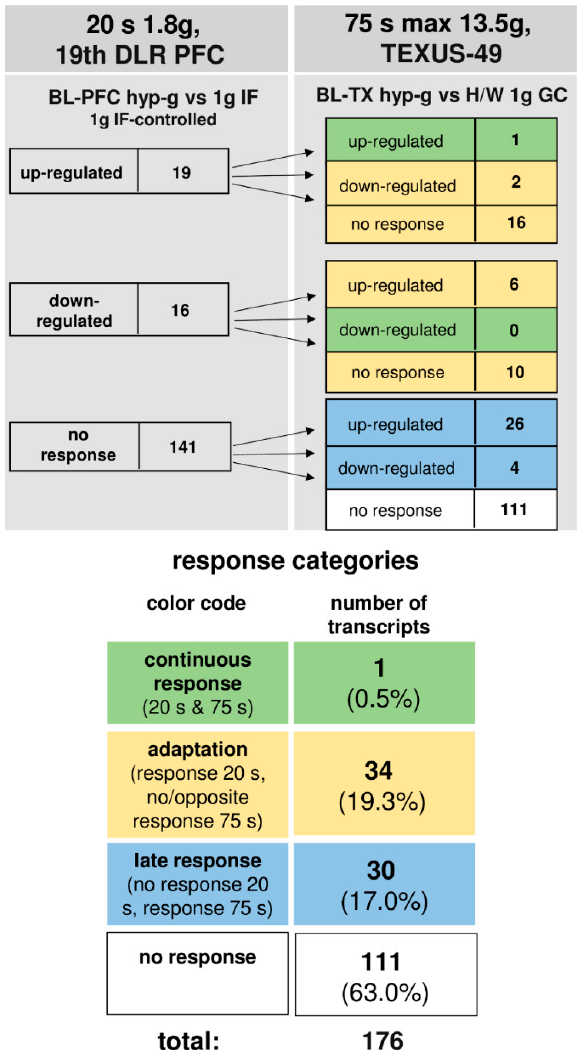
Figure 4. Time course of differential expression of 188 transcripts involved in oxidative stress response during hypergravity (list of genes in Supplementary Table S8). Human myelomonocytic U937 cells were exposed to 20 s and 75 s of hypergravity. The transcripts are grouped according to their regulation after the two exposure times. Continuous response means that the transcripts are either up-regulated or down-regulated at both time points. Adaptation is either the disappearance of the hypergravity-induced effect or regulation in the opposite direction after 75 s. Late response is a regulation that only appears after 75 s. Twelve transcripts out of the 188 do not appear in this scheme, as here, the maximally controlled pools are depicted where the transcripts differentially expressed in the control comparisons are eliminated. Most of the transcripts did not respond to hypergravity at either time point. For the abbreviations of the experiment group names see Table 1.